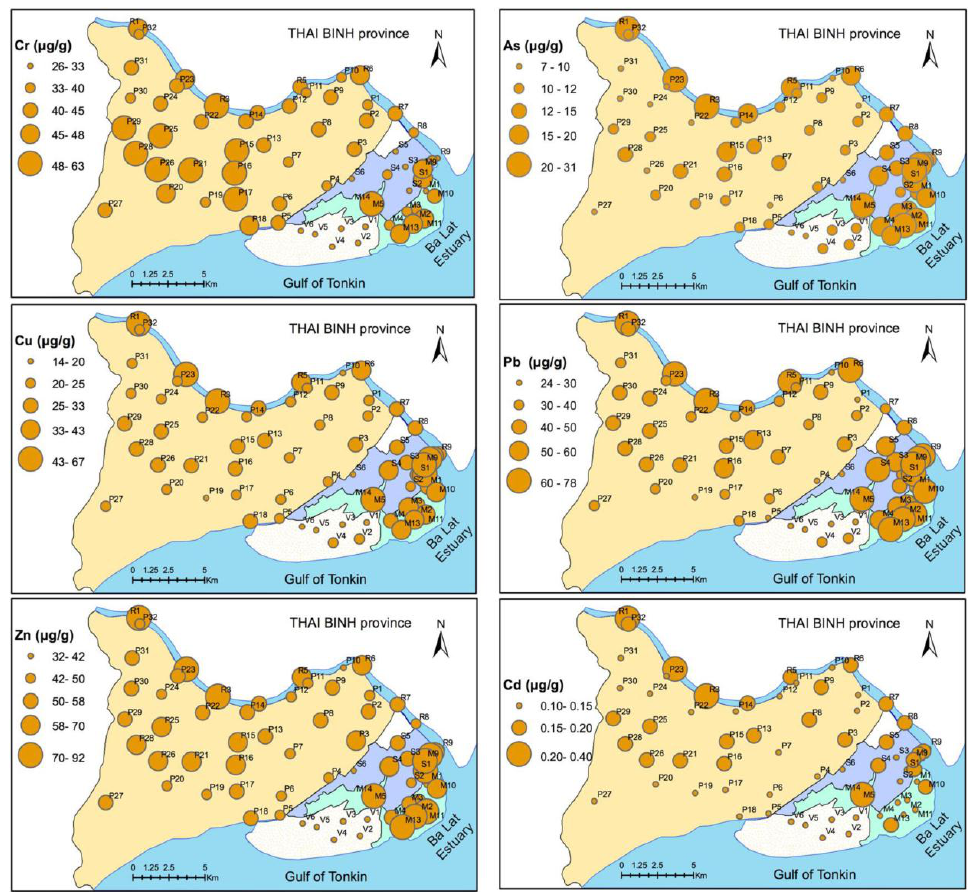
Figure 4. Spatial distribution of heavy metals in the soil of five land uses.